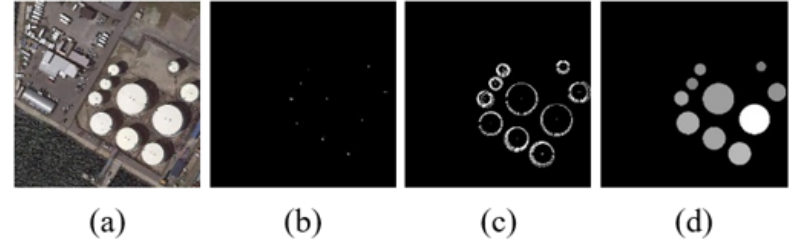
Figure 5. ( a ) is the input image, ( b ) is the center point map, ( c ) is the candidate map, and ( d ) is the final circular feature